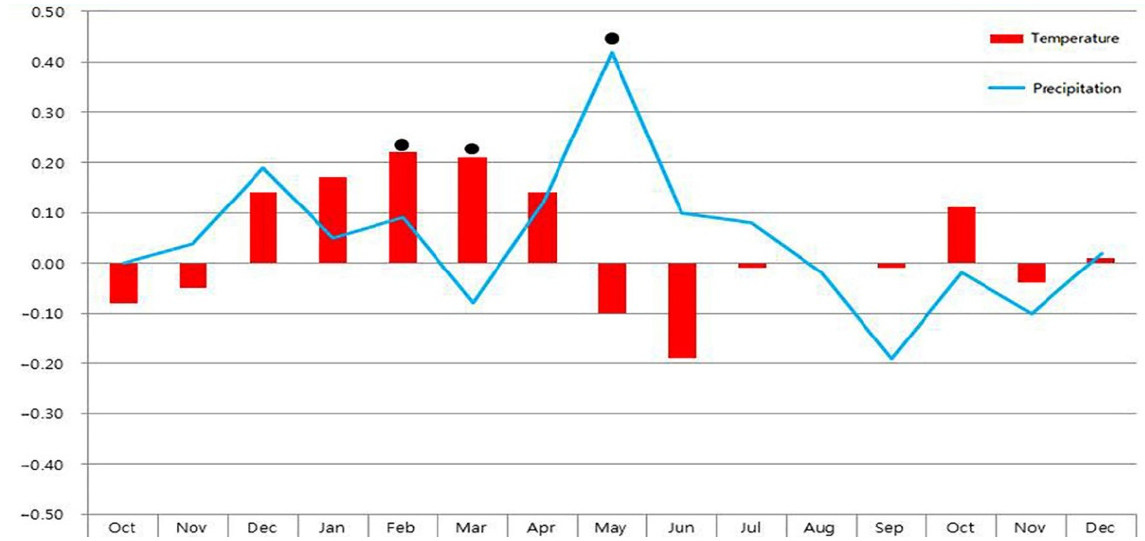
Figure 6. The correlation between climate data and tree-ring chronology of P. densiflora from Mt. Seorak (significant correlations ( p < 0.05) are indicated with black dots).